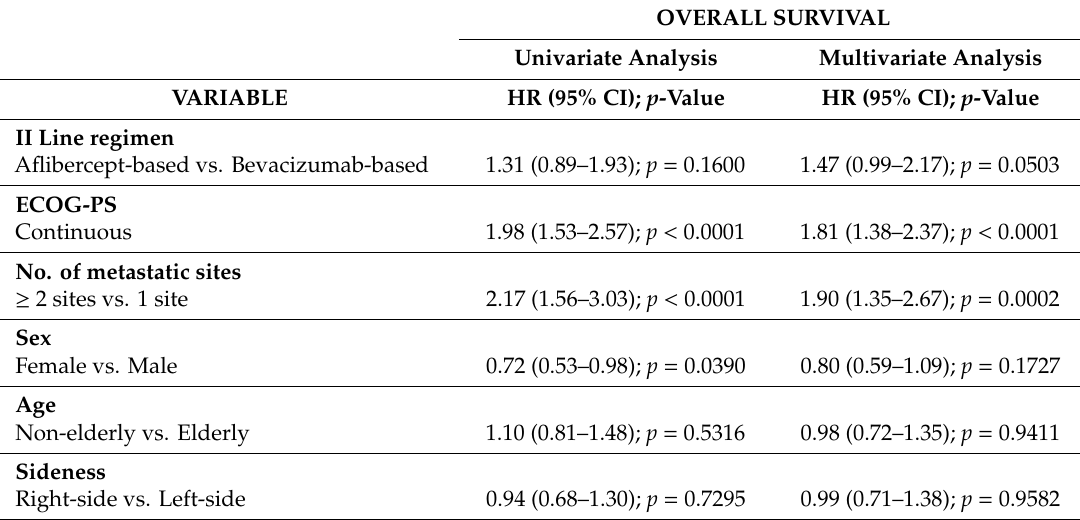
Table 4. Univariate and multivariate analysis for overall survival.